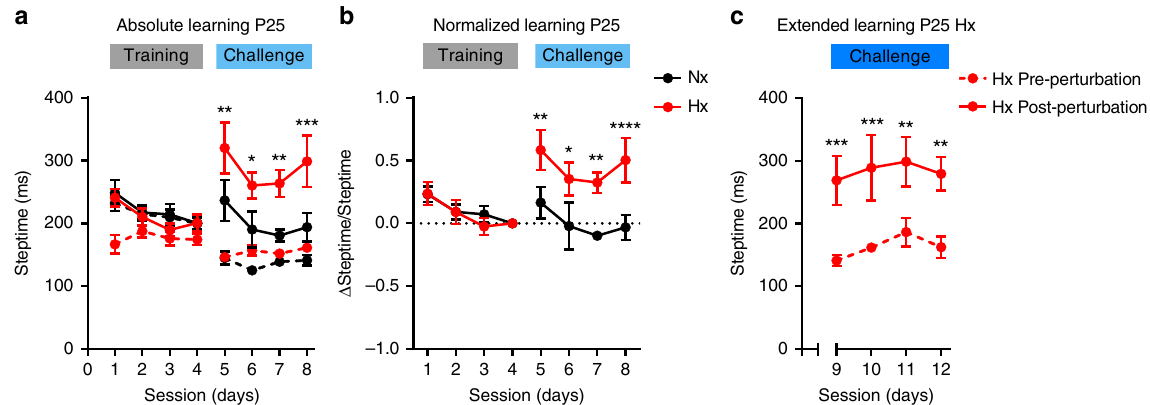
Fig. 3 A conditioned learning paradigm using the Erasmus Ladder reveals adaptive cerebellar learning de fi cits in P25 Hx mice. a Absolute learning in P25 mice measured as a function of post-perturbation steptimes in Nx (black, solid) and Hx (red, solid) mice. Pre-perturbation steptimes (dashed traces) represent internal controls for Nx (black) and Hx (red). Nx: n = 8 animals, Hx: n = 11 animals. Statistics: two-way repeated measures (RM)